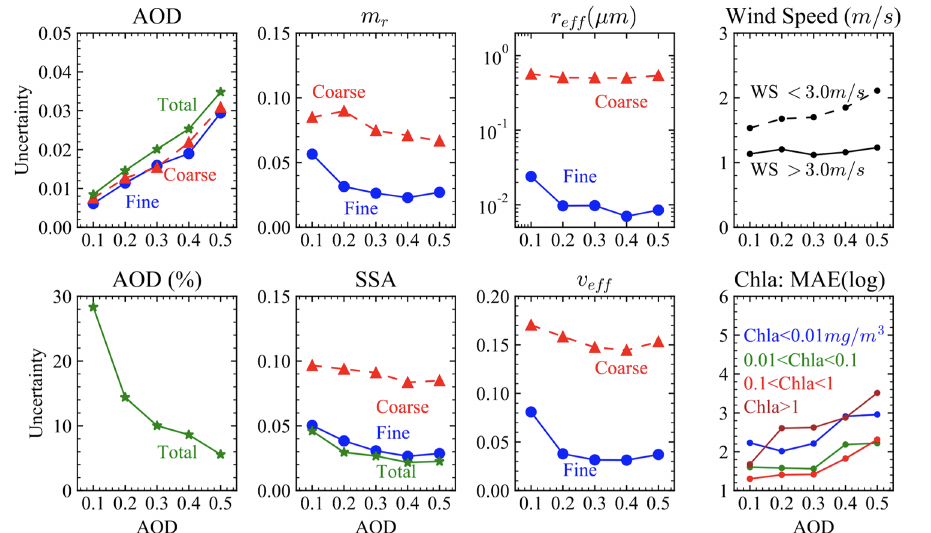
Figure 9. The retrieval uncertainties at various aerosol loadings for AOD, SSA, refractive index ( m r ), effective radius ( r eff ) and variance ( v eff ), wind speed, and Chl a . AOD values at the x axis from 0.1 to 0.5 indicate the five ranges of total AOD including [0.01, 0.1], [0.1, 0.2], [0.2, 0.3], [0.3, 0.4], and [0.4, 0.5], which are used to compute the corresponding uncertainties. Chl a uncertainties are evaluated in terms of MAE in log scale (see Eq. 22), and all other parameters are evaluated in terms of RMSE. AOD (%) indicates the percentage AOD uncertainties comparing to the truth AOD.